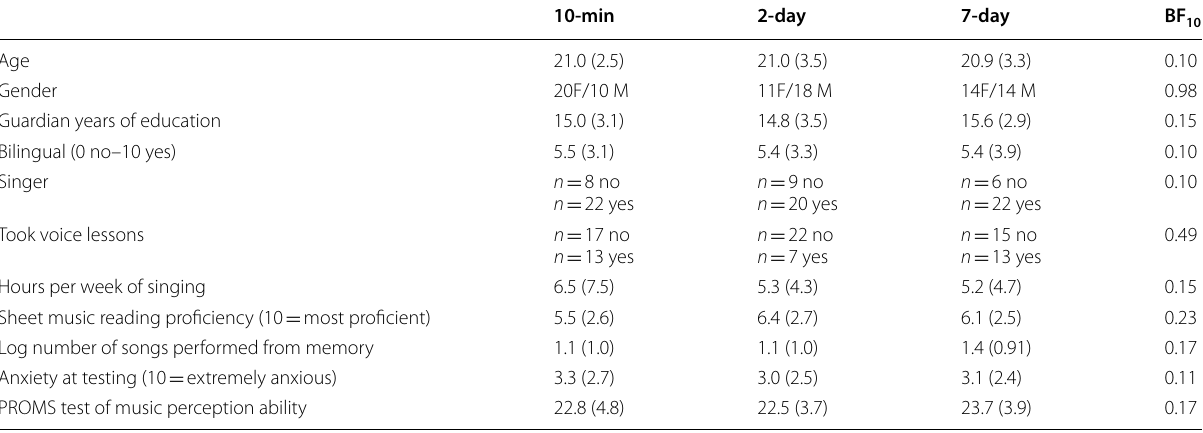
Table 5 Demographic characteristics of experimental groups